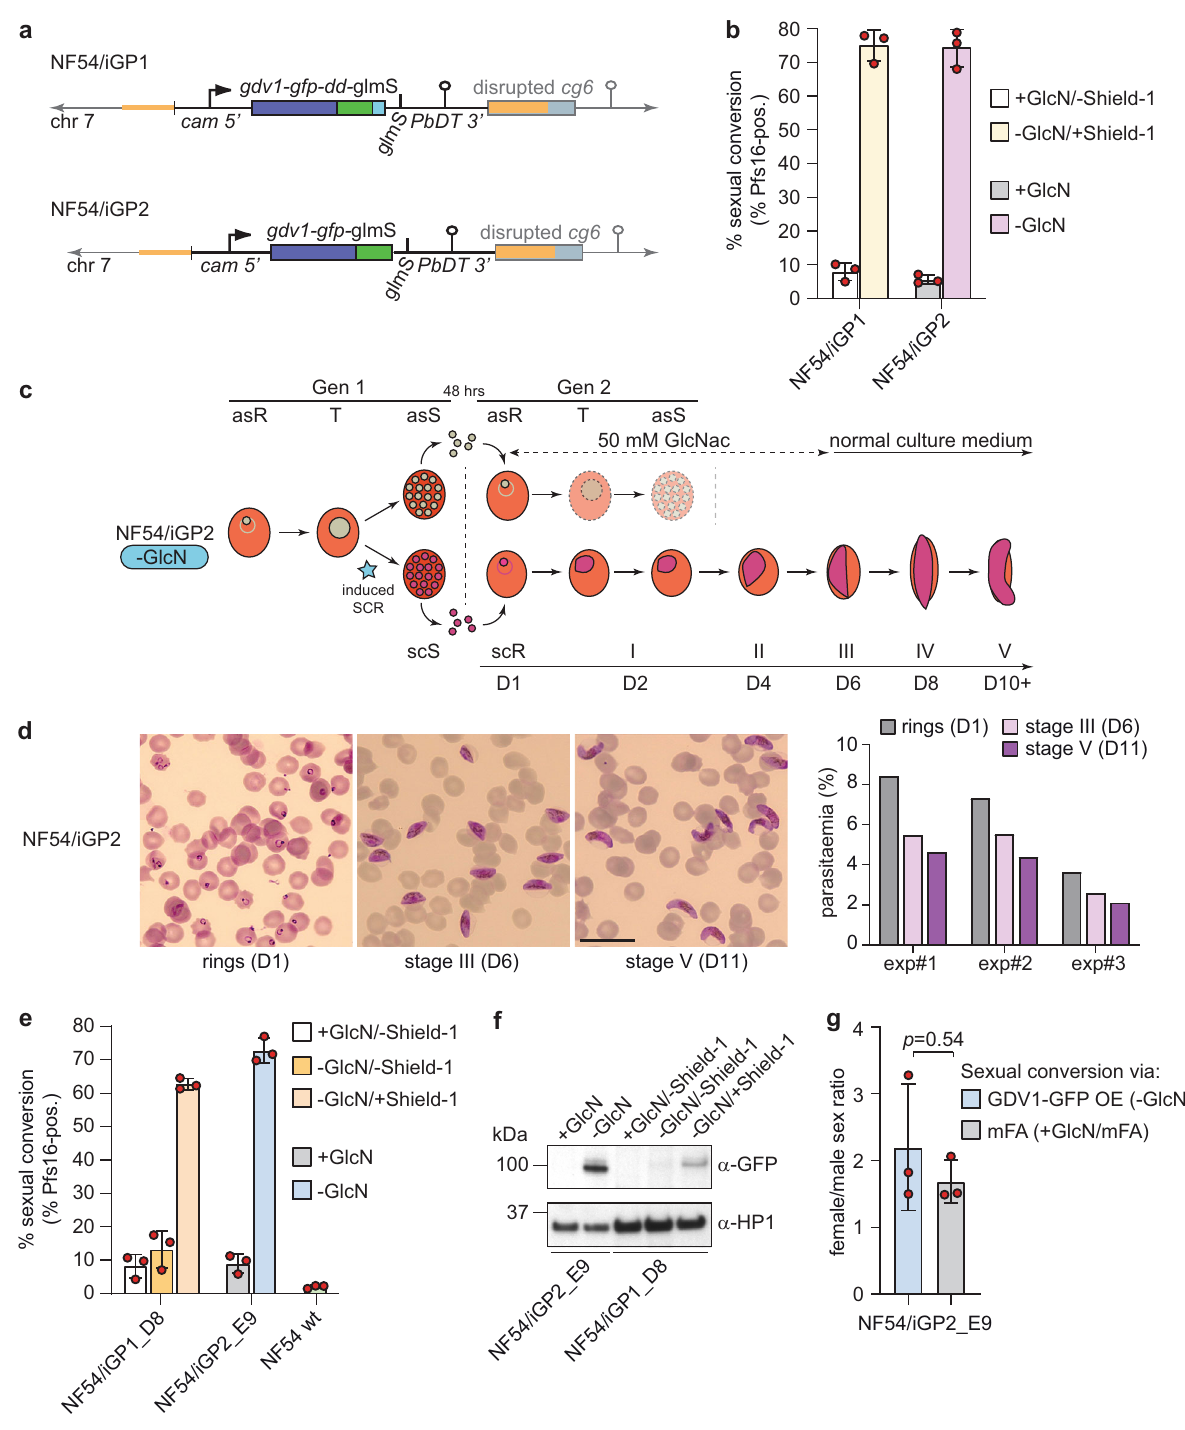
ratios between NF54/iGP2_E9 gametocytes obtained via GDV1- GFP overexpression ( − GlcN; 2.2 ±0.8 s.d.) or via induction